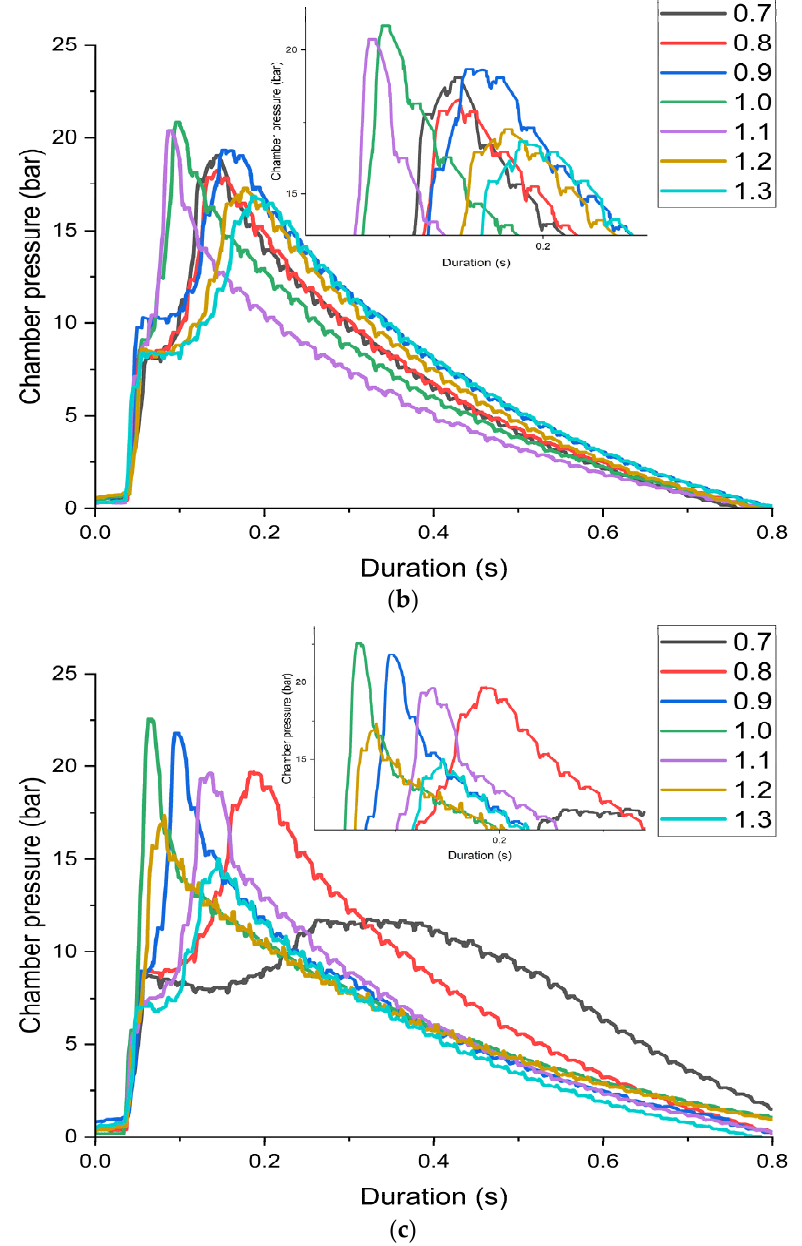
Figure 6. Chamber pressures of different BPGs at 𝜙 from 0.7 to 1.3: ( a ) WP; ( b ) CH; ( c ) PKS.